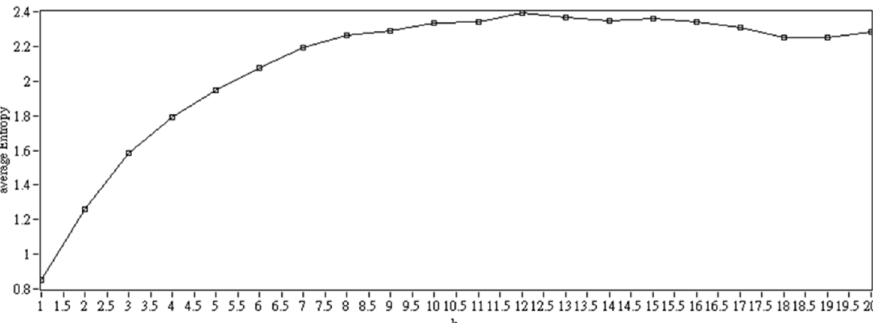
Figure 2. Example of different time scale E( k = 1~20) of iPR.